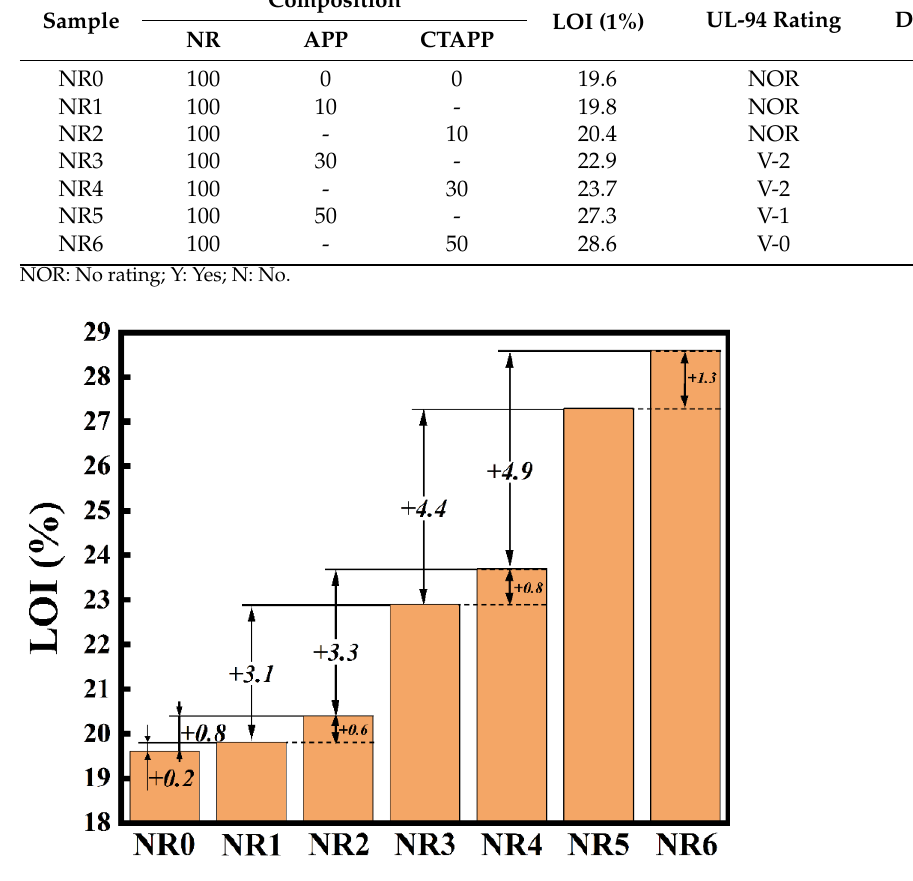
Figure 3. LOI Trend analysis results.